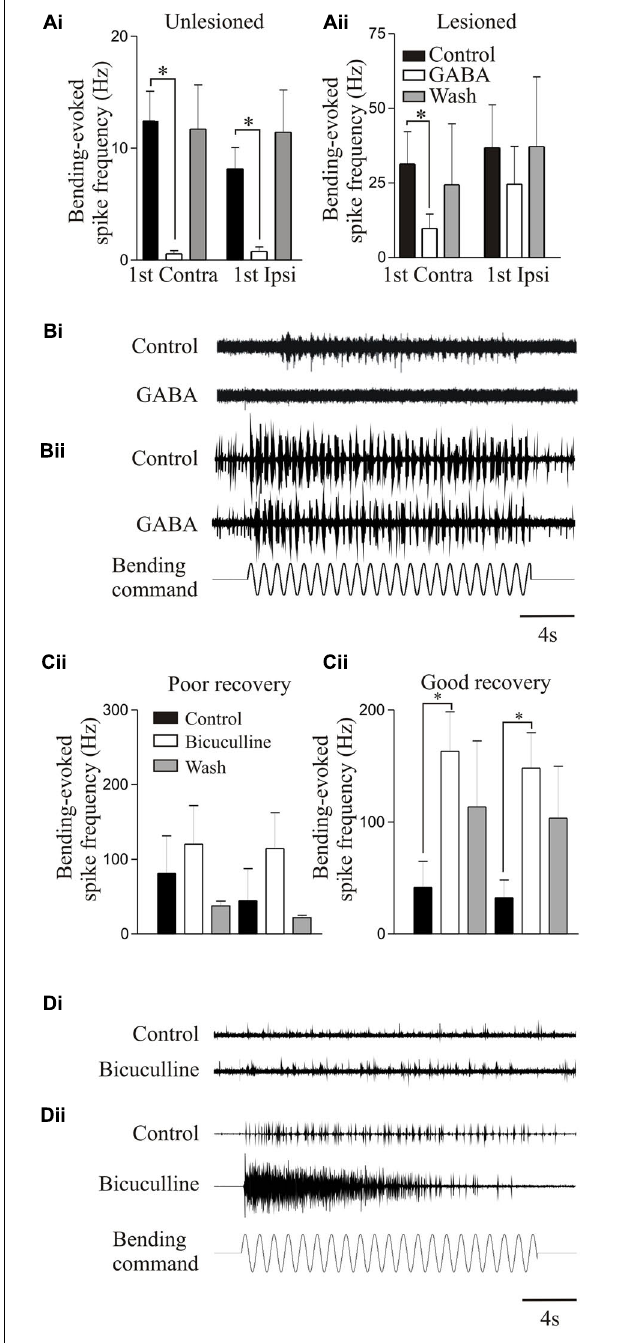
FIGURE 7 | Modulation of proprioceptive activity. (Ai,Aii) The effect of GABA on bending-evoked activity recorded from the lateral margin of the spinal cord. Notice that GABA effects are weaker in lesioned animals. Traces showing proprioceptive activity in an unlesioned (Bi) and a lesioned animal (Bii) . (Ci,Cii) The effects of bicuculline on bending-evoked activity depended on the degree of recovery: note that bicuculline effects are only significant in lesioned animals that showed good recovery. Traces showing the effects of bicuculline on bending-evoked activity in animals that showed poor (Di) and good recovery (Dii) . Data from Svensson et al. (2013). Permission granted to reproduce. ∗ Indicates statistical significance at p <